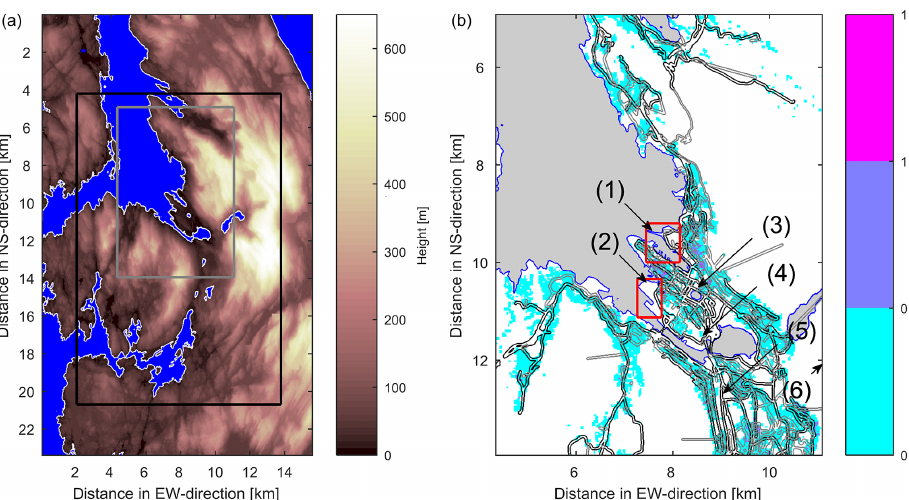
Figure 1. (a) Topographic map of the Bergen area. The black square indicates the final model domain used for the PALM simulations; the gray square indicates the focus area for the analysis of the PALM simulations. (b) Emission map for Bergen city centre used in the PALM simulations. Colour shading indicates the number of parcels of land with registered active fireplaces (for domestic heating) per 10 × 10m 2 grid square. Black/gray lines indicate the location of main/side roads. The main harbour areas, Jekteviken (southwest, 2) and Skolten (northeast, 1), are indicated with two red squares. The numbered arrows point at the location of the automatic weather stations at (1) Skolten, (2) Jekteviken, (4) Florida and (6) Ulriken, and the air pollution stations at (3) Rådhuset and (5)